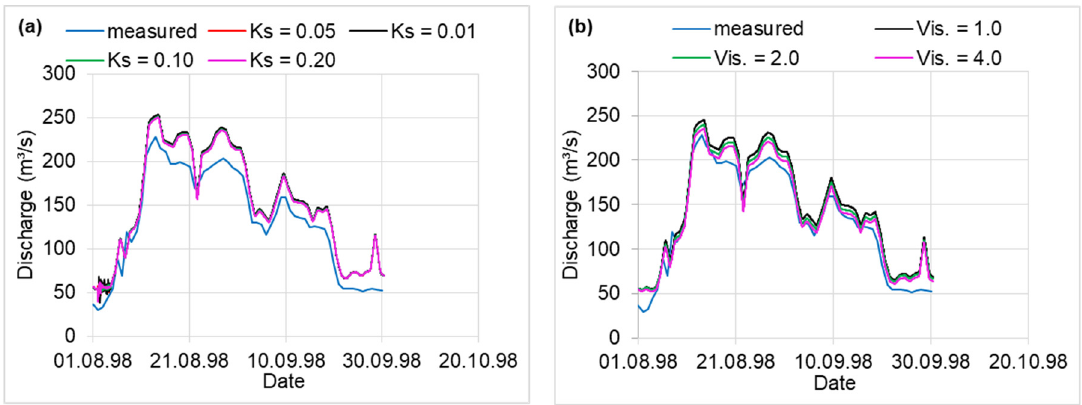
Figure 6. Model calibration: measured discharge hydrograph of summer 1998 at Wonji gauging station ( a ) compared with modelled discharge hydrographs for different Nikuradse’s roughness Ks-values, ( b ) compared with modelled discharge hydrographs for different eddy viscosity values (Vis.).